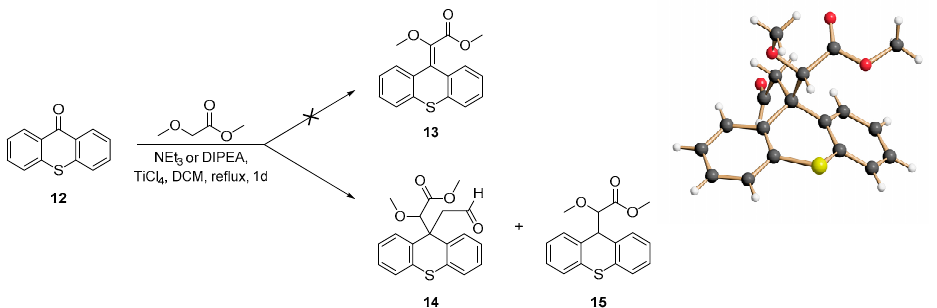
Table 1. Low-energy (red-shifted) absorption wavelengths ( λ abs max ), corresponding absorption coefficients ( ε ), excitation wavelengths ( λ ex ), emission maxima ( λ em max ), and fluorescence quantum yields Φ F of ( 7 ), ( 8 ), and ( 10 ) without ( − ) and with (+) 500 eq. of TFA. The data highlighted in yellow are from the experiments without acid